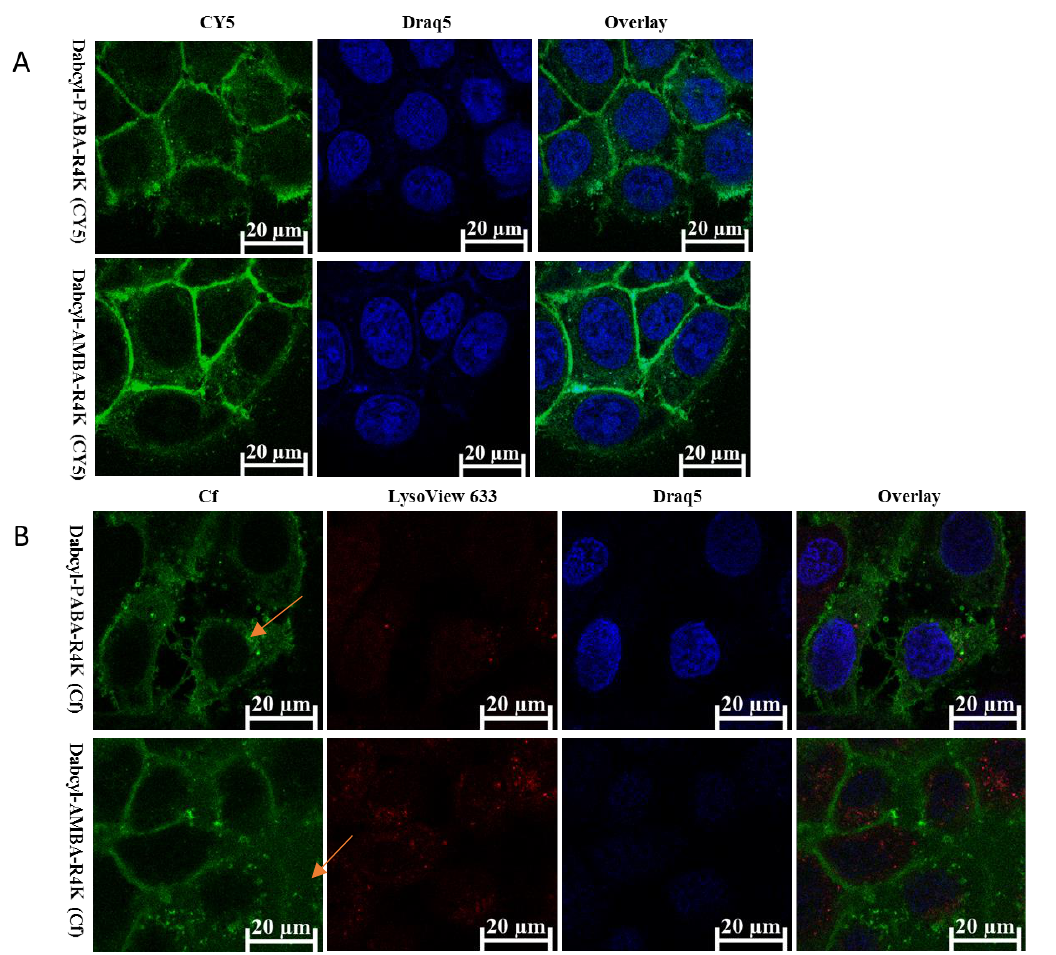
Figure 5. Cellular distribution of peptides on FADU cells visualized by confocal microscopy. Cells were incubated with the fluorescent peptide conjugates (5 µM). ( A ) Cells were treated with CY5-labelled peptides (green) for 1h and nuclei were stained with Draq5 (blue). ( B ) Visualization of vesicular uptake, cells were treated with Cf-labelled peptides (green) for 3 h and nuclei were stained with Draq5 (blue) while lysosomes were stained with LysoView 633. Imaging was performed by a Zeiss LSM 710 system. Orange arrows: unfamiliar bubble-like structures that formed after the treatment with the peptide